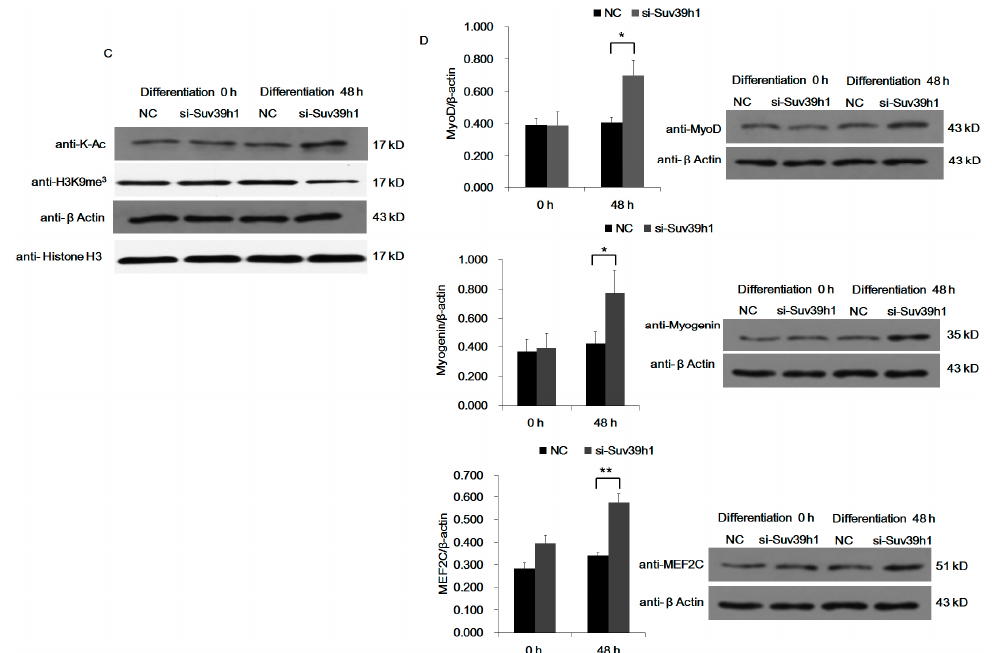
Figure 4. Knock-down of Suv39h1 stimulated skeletal muscle differentiation. ( A ) C2C12 cells were transfected with siRNA against Suv39h1 (si-Suv39h1) with a fluorescent label (FAM) or control siRNA (NC) as a control and maintained in differentiation medium (2% HS) after transfection for 30 h. The cells were stained with anti-Cy3 antibody which was against the primary anti-MHC antibody (Red) after differentiation for eight days. The red Cy3-stained cells presented the level of MHC protein. Western blot analyses were performed using antibody that recognized the indicated proteins; ( B ) The influence of Suv39h1 knock-down on the cell cycle phase of C2C12 cells. After transfection 48 h, C2C12 cells were detected by FCM, and the cell cycle phase was analyzed. Then, the differences in cell populations and proliferation indices between two groups were displayed by graph. C2C12 cells were transfected with siRNA against Suv39h1 or NC. Cells were transferred to differentiation medium for the indicated time, and the levels of histone modifications ( C ); and myogenic differentiation proteins ( D ) were analyzed by Western blot. β -actin and histone H3 were used as a loading control. The quantification on Western blot of indicated proteins were normalized to β -actin. Bars represent the mean ± SD of three experiments. The statistical significance of the differences values was analyzed by Student’s t -test, * p < 0.05, ** p < 0.01.